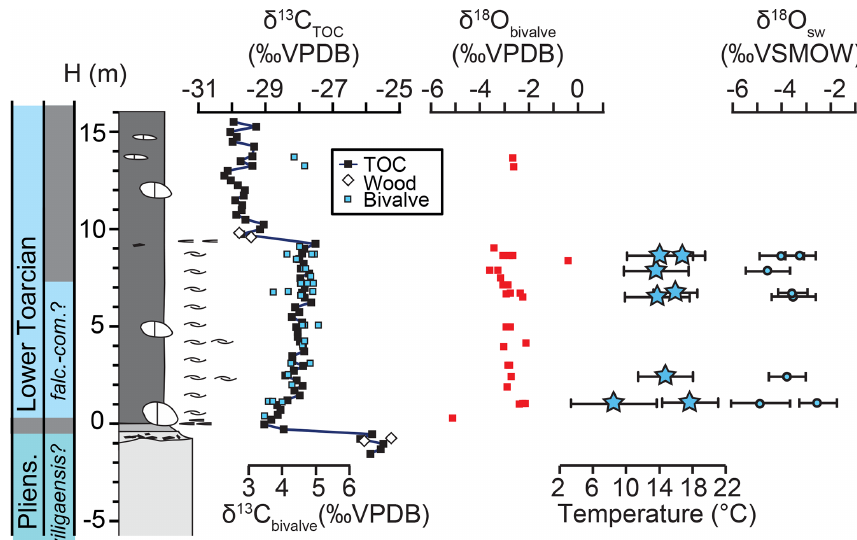
Figure 4. Geochemical record of the T-OAE at the Polovinnaya River, Arctic Siberia. Stratigraphy and biostratigraphic zones are for the Arctic realm (falc.: falciferum zone, com.: commune zone). The organic carbon isotope ( δ 13 C TOC ) data (black squares) and wood debris δ 13 C data (white diamonds) are from Suan et al. (2011); the bivalve shell δ 13 C data (blue squares), bivalve shell δ 18 O (red squares), (cid:49) 47 temperatures (blue stars), and δ 18 O w estimates (blue circles) inferred from bivalve shell (cid:49) 47 values are from this study. The analysed bivalve samples all belong to the species Dacryomya jacutica . (cid:49) 47 -derived temperatures were computed using the equation of Anderson et al. (2021). δ 18 O w was calculated using the oxygen isotope fractionation equation of Grossman and Ku